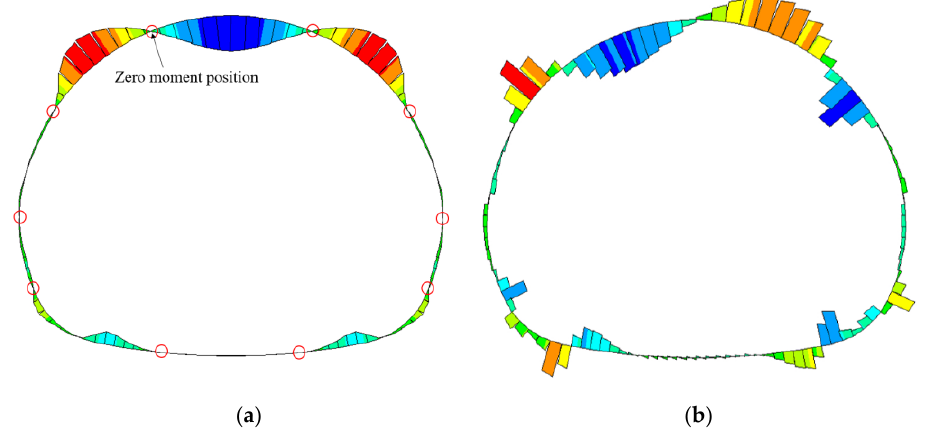
Figure 15. Internal force diagram of primary support structure. ( a ) Bending moment diagram and ( b ) shear force diagram. ( b ) shear force